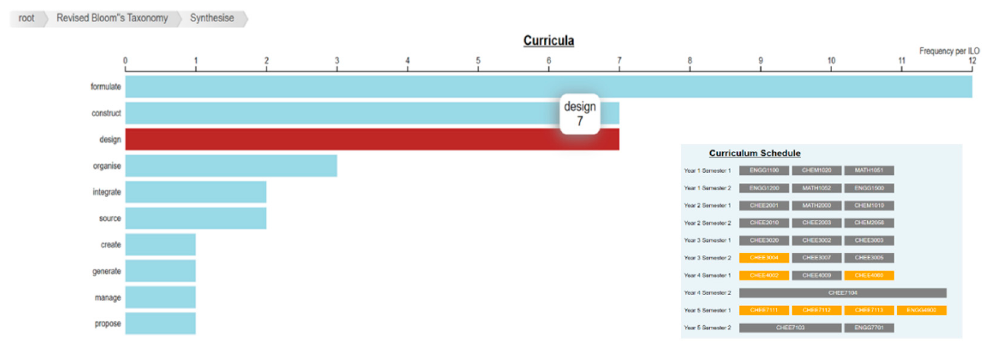
Figure 12. Attainment levels and distribution across the curriculum.